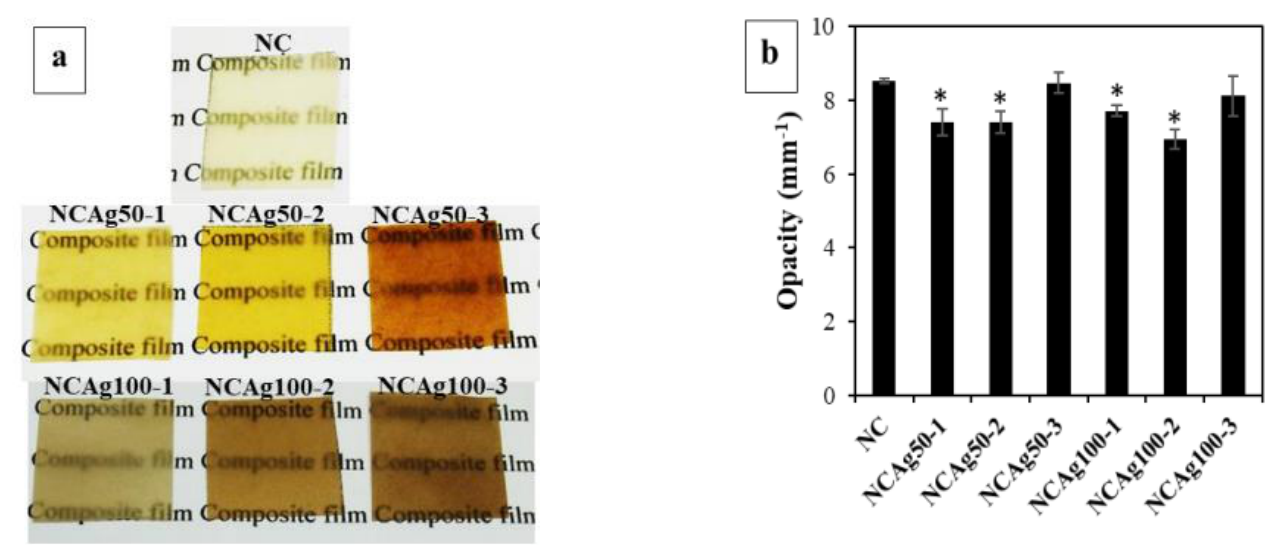
Figure 2. Photographs ( a ) and degree of opacity ( b ) of NC, NCAg50, and NCAg100 films. The symbol * indicates a significant difference ( p < 0.05, n = 5) versus NC.